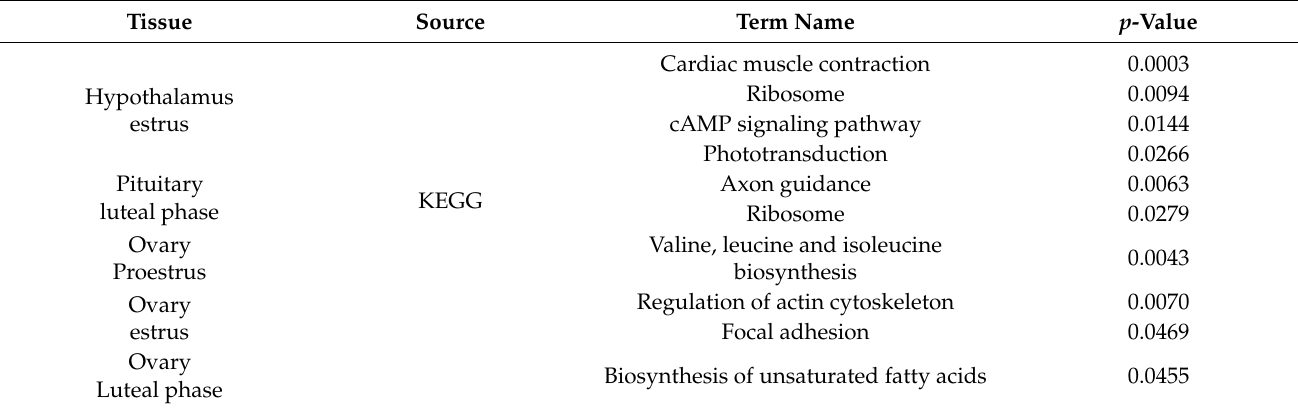
Table 2. The significantly enriched pathways of KEGG